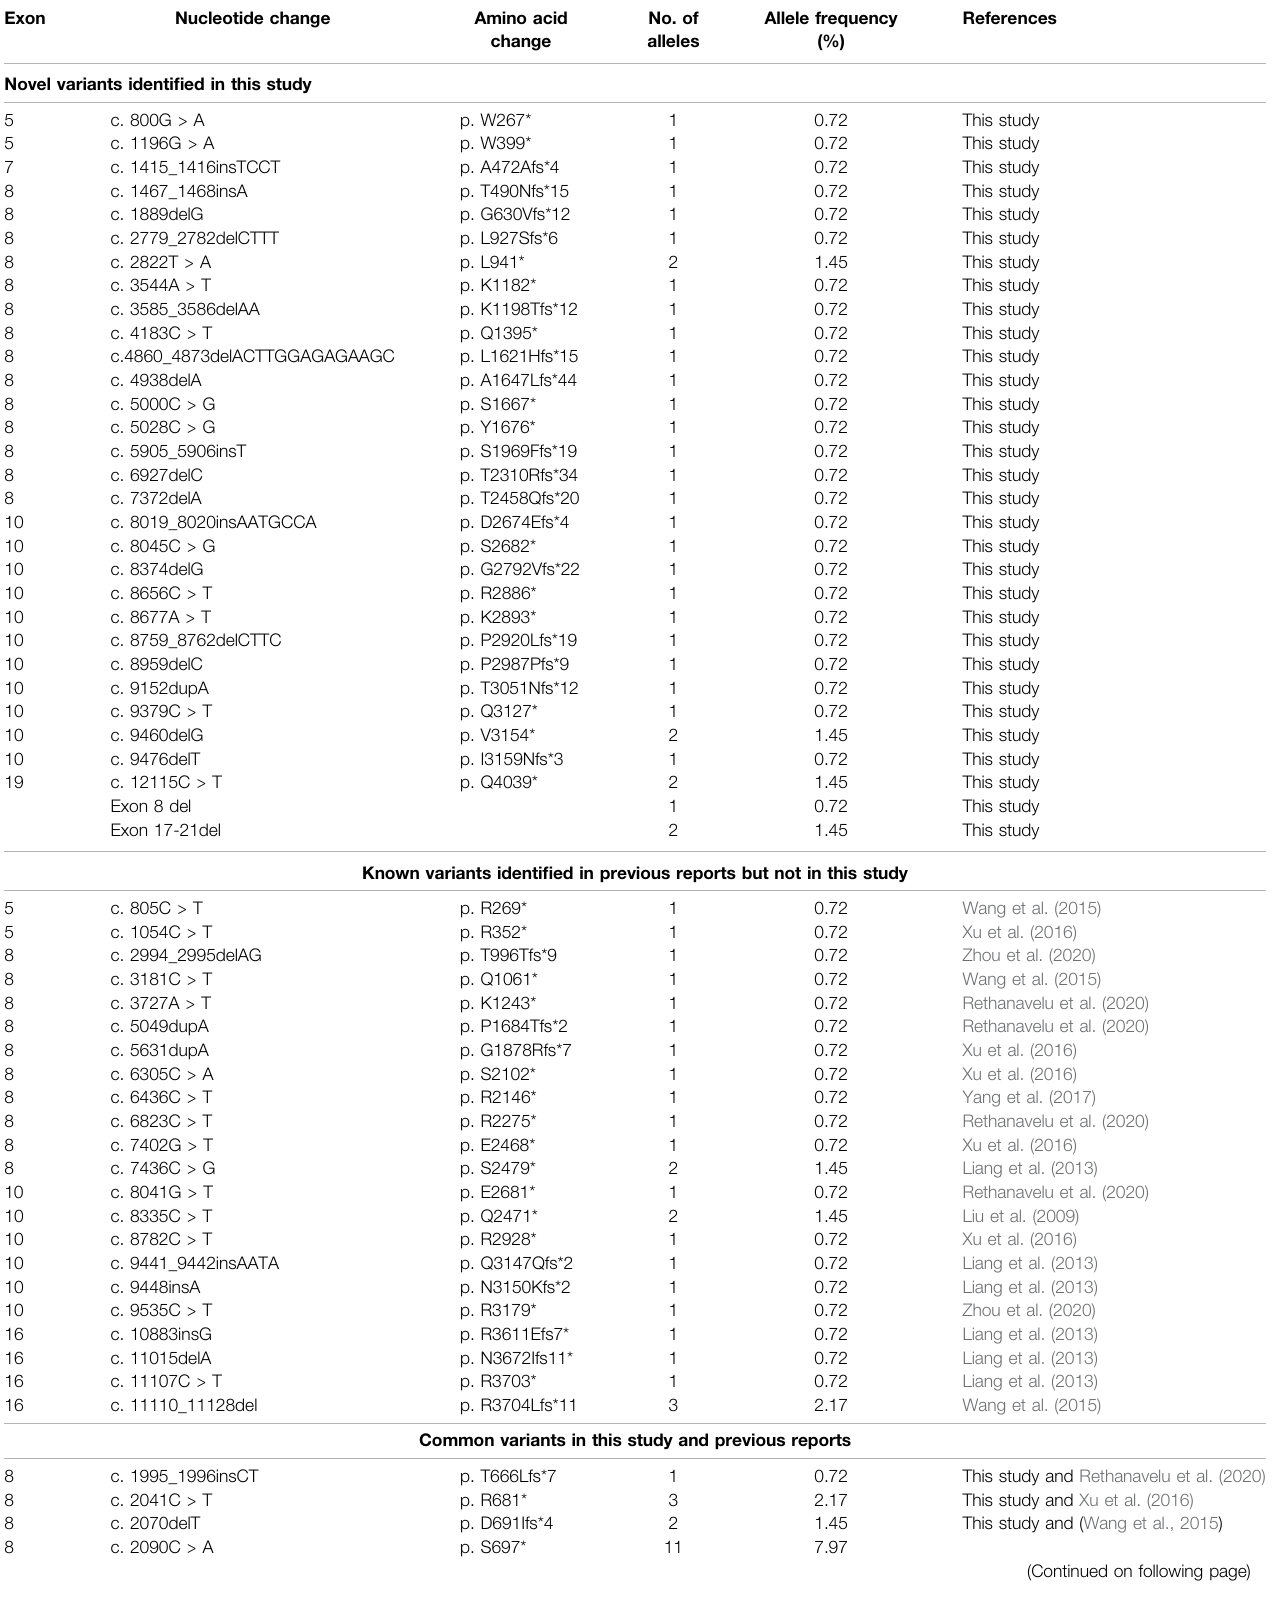
TABLE 3 | Summary of ALMS1 variants in 69 Chinese ALMS families (47families in this study and 22 families in previous